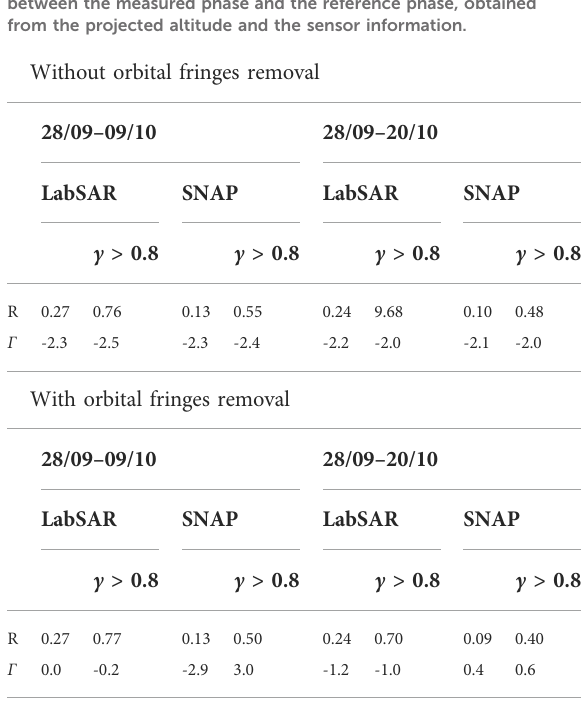
TABLE 2 Statistics of the histograms of the pixel-wise comparison between the measured phase and the reference phase, obtained from the projected altitude and the sensor